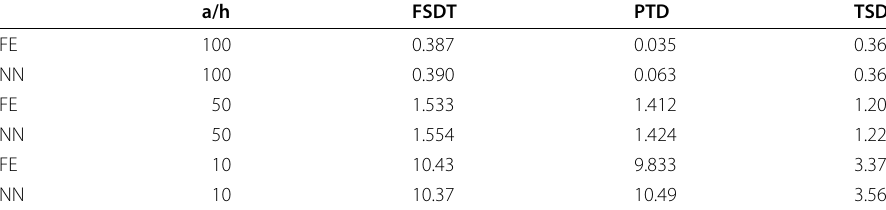
Table11 0/90/0/90, influence of a/h on some particular cases from Figs. 13, 14 and 15